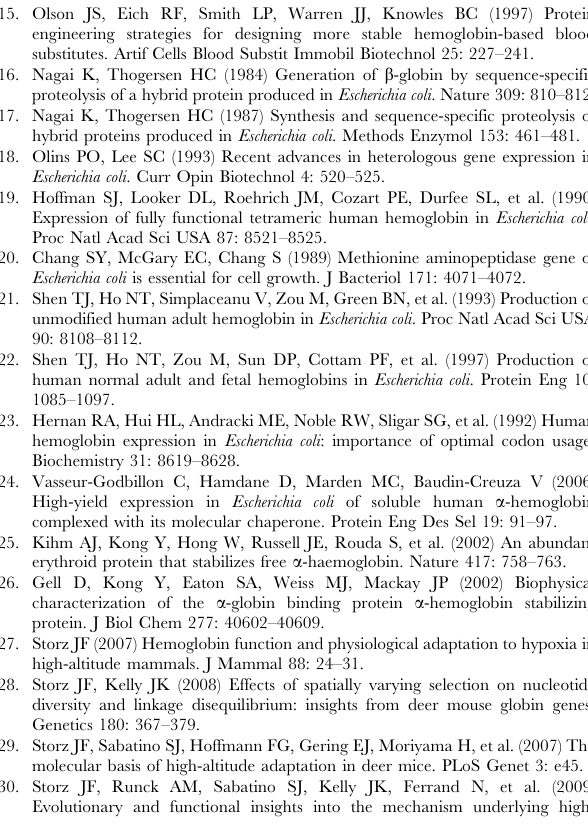
Figure S1 Optimization of HH rHb expression in E. coli . (a) 16% SDS-PAGE image showing the expression profile of HH rHbs in different E. coli strains. Lane M, BioRad size standards; Lanes SF and ISF correspond to the soluble and insoluble fraction of rHbs in each of five different E. coli strains: (A)